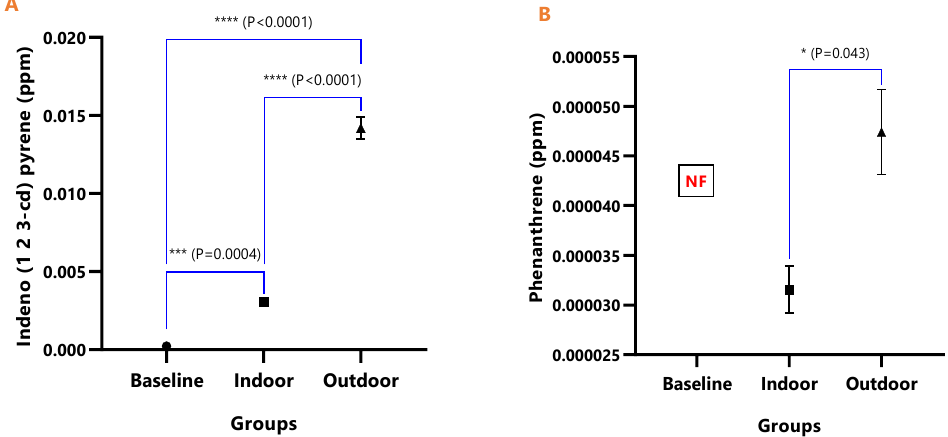
Figure 9. The mean concentrations and test of mean difference for ( A ) Indeno (1 2 3-cd) pyrene and ( B ) Phenanthrene in the various animal groups.